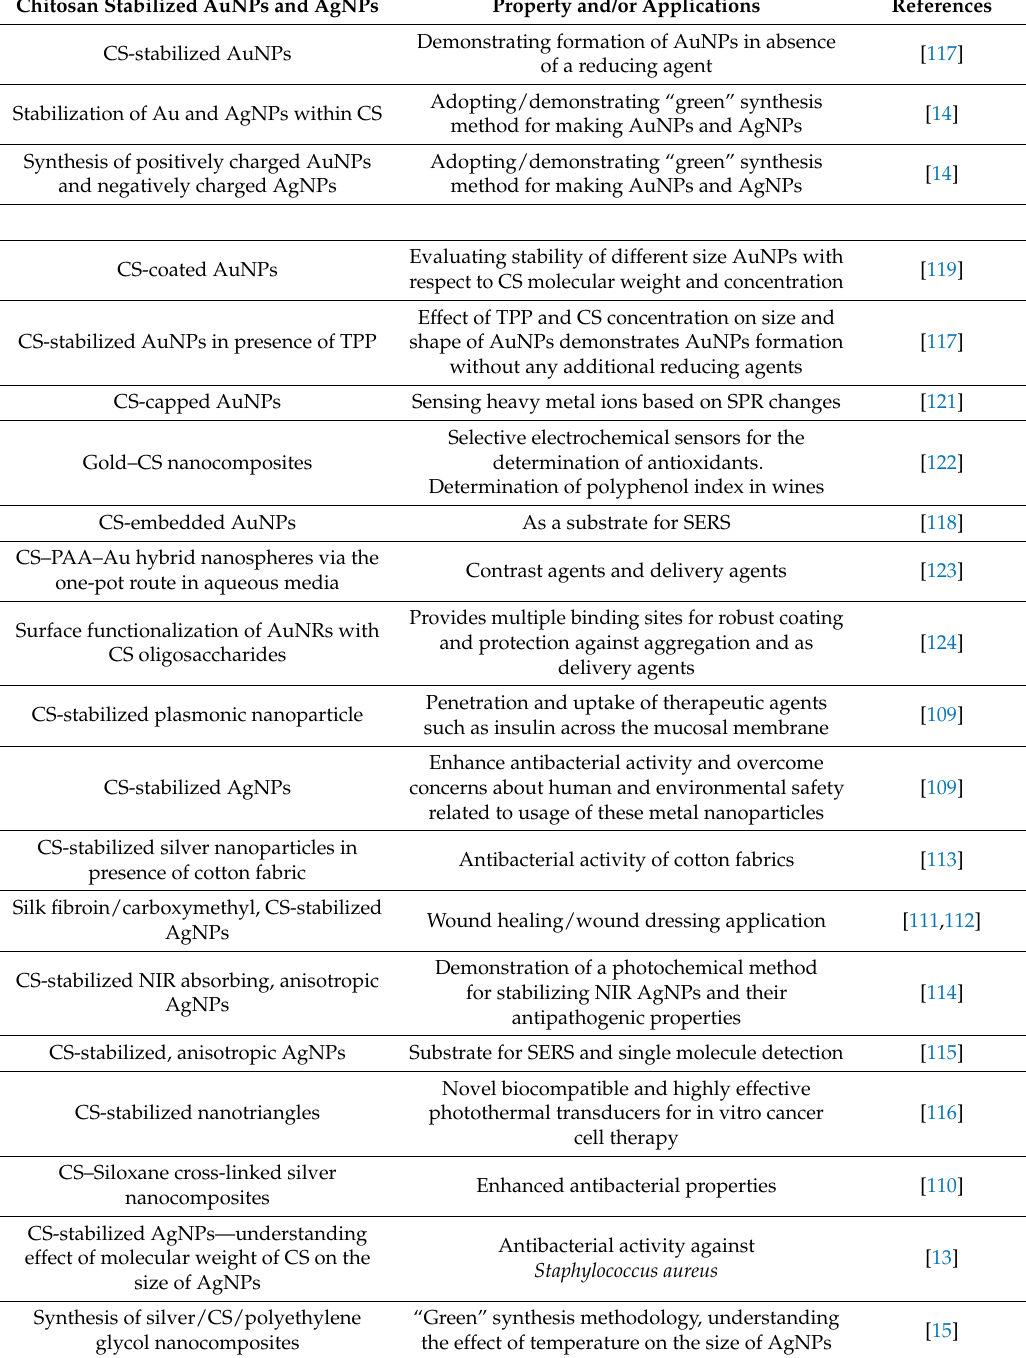
Table 3. Selective methods for synthesis of CS-stabilized gold (AuNPs) and silver nanoparticles (AgNPs) and their corresponding